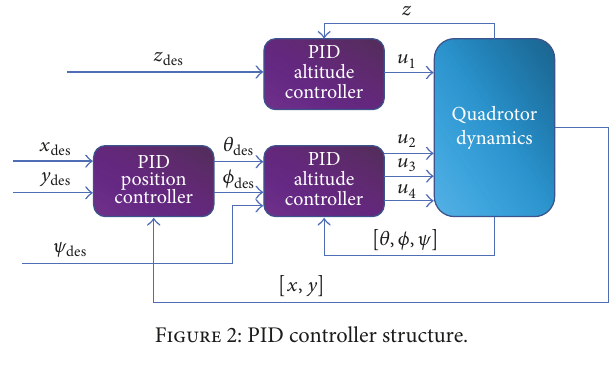
Figure 2: PID controller